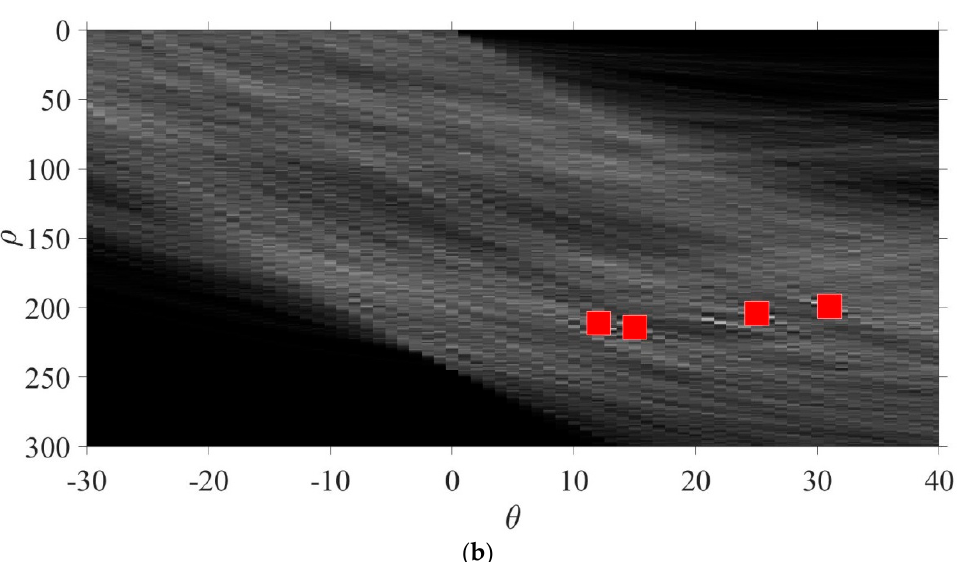
Figure 15. Hough space of the target object in ( a ) the out-of-water; and ( b ) the underwater environment, respectively.